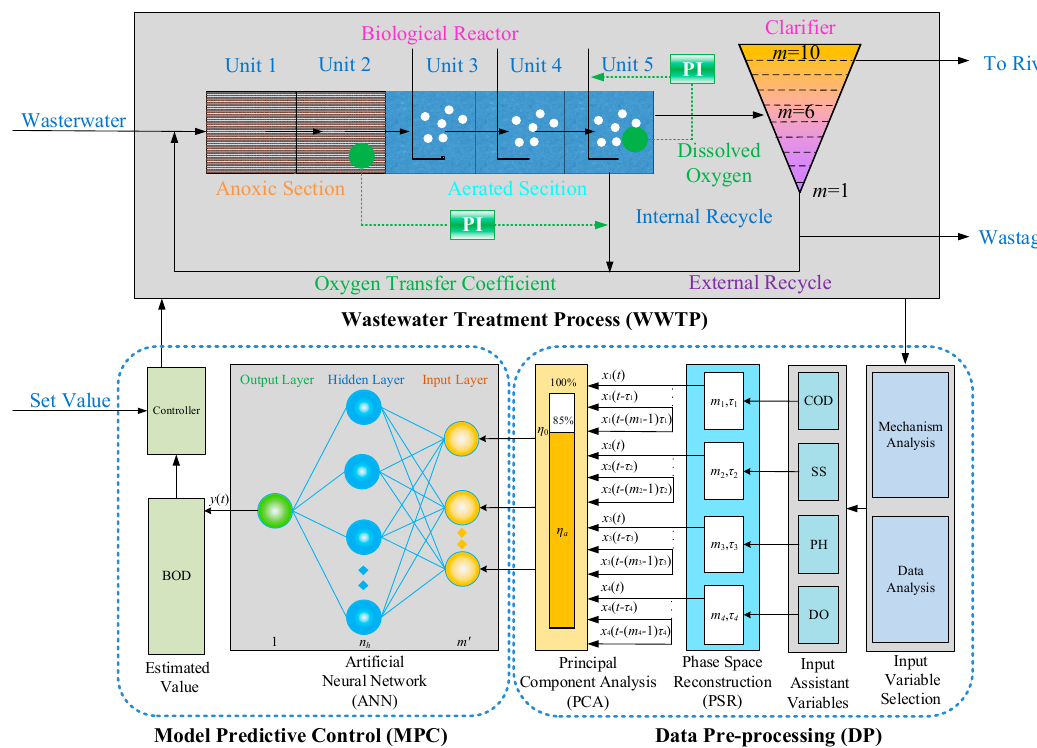
Figure 2. The structure of the prediction model based on chaos theory for BOD with PCA ‐ ANN.